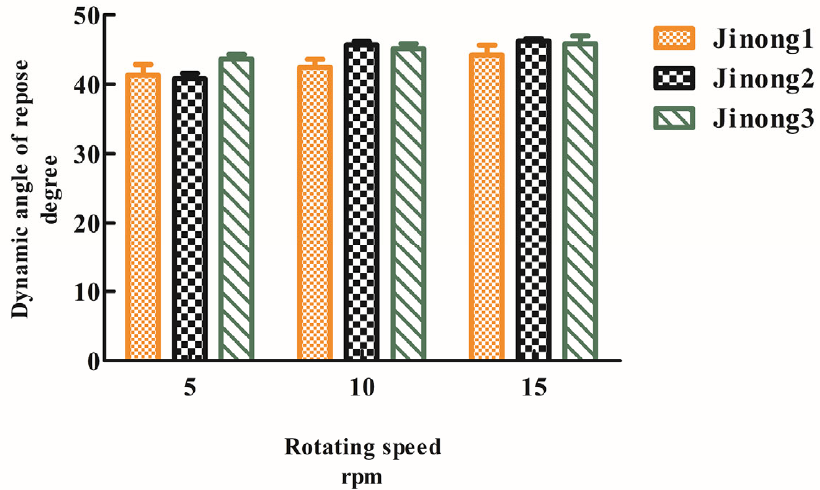
Figure 11. Dynamic angle of repose for the Cyperus esculentus seeds.